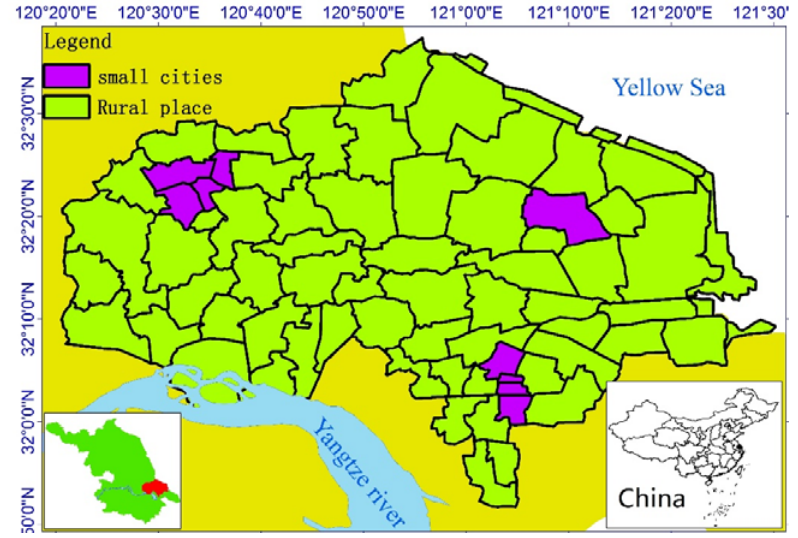
Figure 1. Research region.